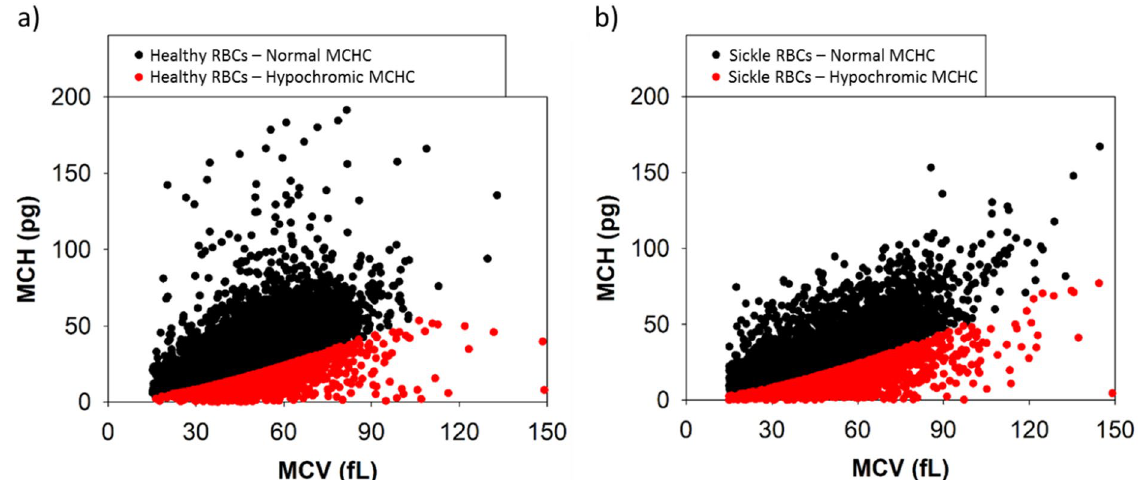
Figure 6. MCH CTV and MCV CTV calculations for ( a ) all healthy RBCs and ( b ) sickle RBCs. Normal (black) cells and hypochromic (red) cells are shown with the cutoff value of 28 g/dL.